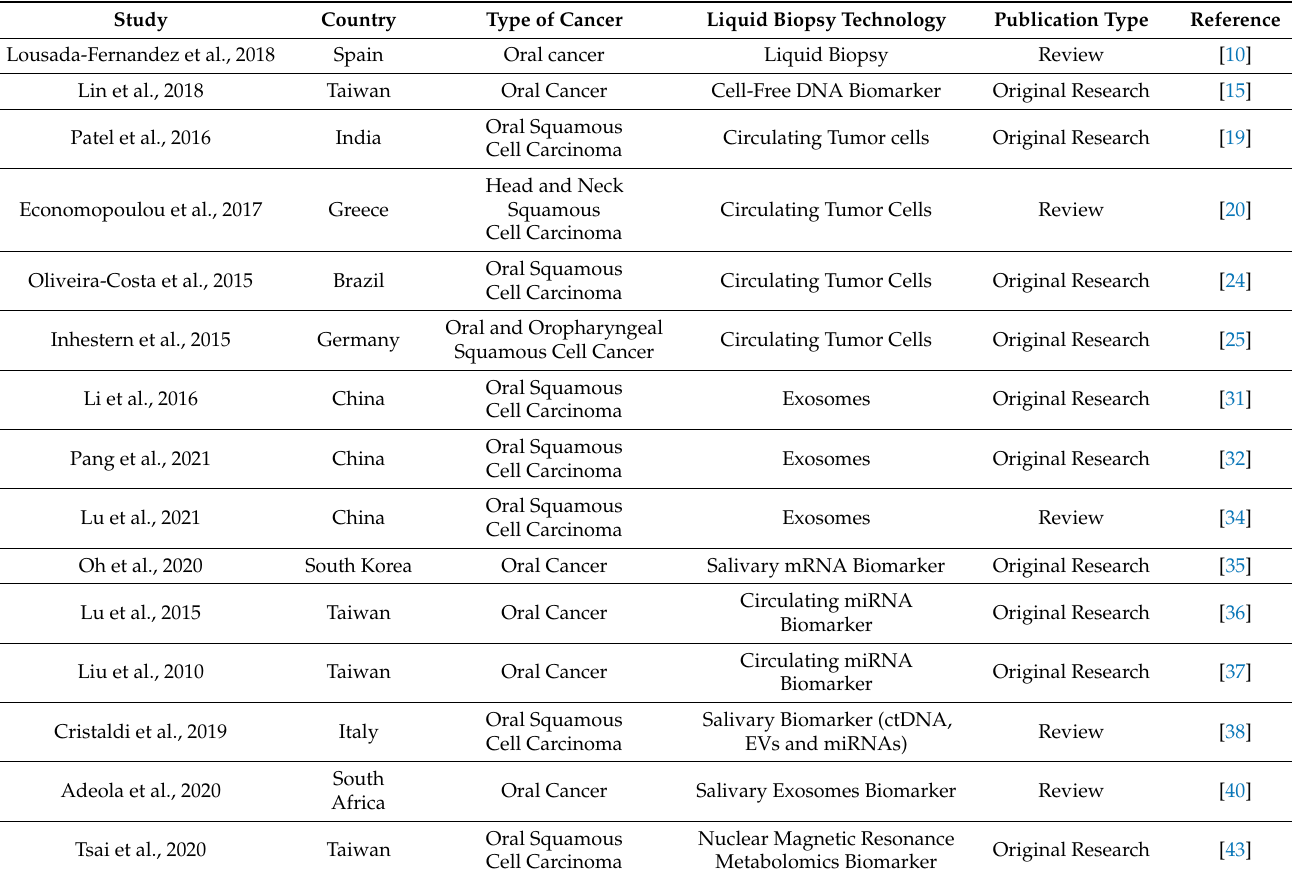
Table 1. Some evidence of the applications of liquid biopsy in oral